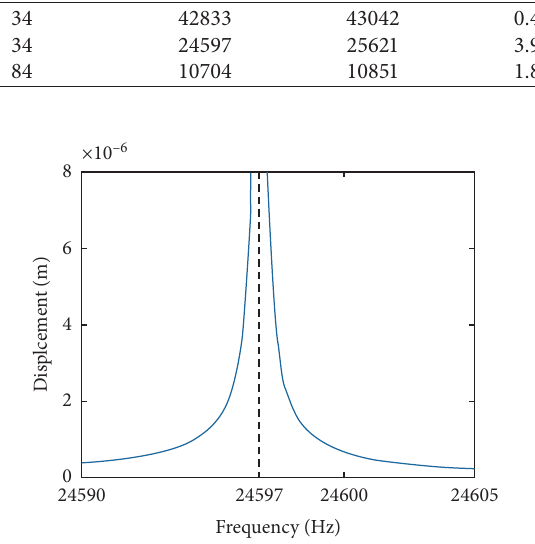
Figure 7: Amplitude-frequency characteristics of the analytical